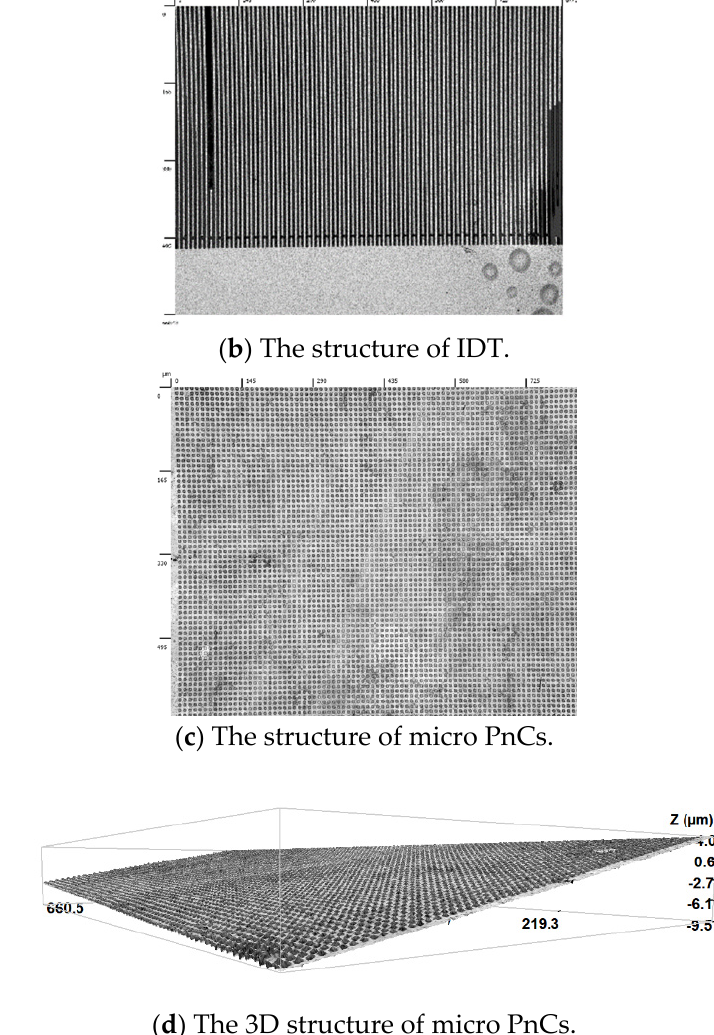
Figure 10. Devices of the Love wave mode delay line and microstructure. The electrical responses were measured by the vector network analyzer (VNA) with the Keysight E5071C. As the direct measurement data had many reflective signals of the bottom, the time domain window was added to extract the useful information. The treated results are demonstrated in Figure 11. From the Figure 11, it can be seen that the main peak has been slant after introducing the micro PnCs, along with a little shift up of the frequency, but with little